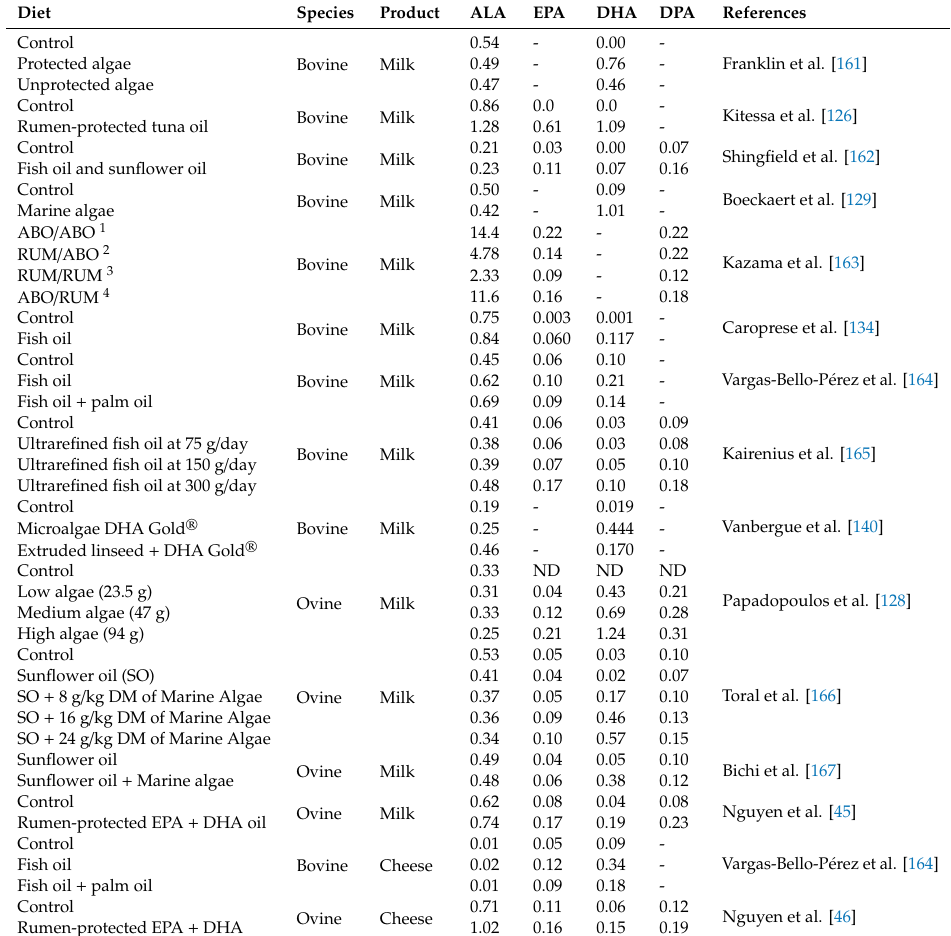
Table 5. E ff ect of supplementing ruminants with dietary marine sources on n-3 PUFA concentration of milk and milk products (g / 100 g fatty